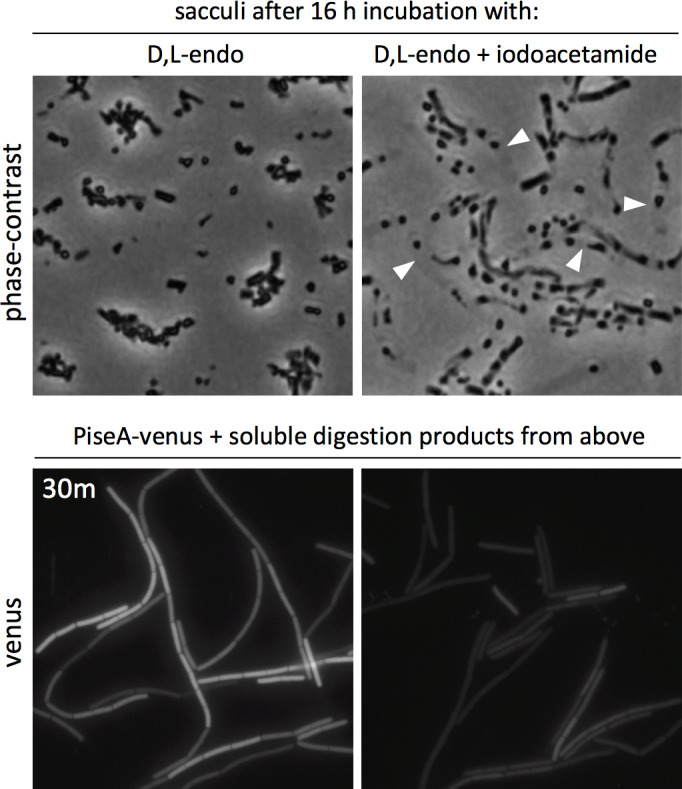
The soluble material after incubating PG sacculi with iodoacetamide-treated CwlO does not lower WalRK activity.Phase-contrast images of purified B. subtilis sacculi incubated overnight at 37°C with purified CwlO∆cc (D,L-endo) or iodoacetamide-inactivated CwlO∆cc (top panels). Translucent sacculi (carets) surrounding phase-dark insoluble aggregates are only visible after incubation with the iodoacetamide-inactivated CwlO∆cc protein. Representative fluorescence images of B. subtilis cells harboring PiseA-venus after 30 min incubation with the soluble material generated from overnight incubation of sacculi under the indicated conditions (bottom panels).